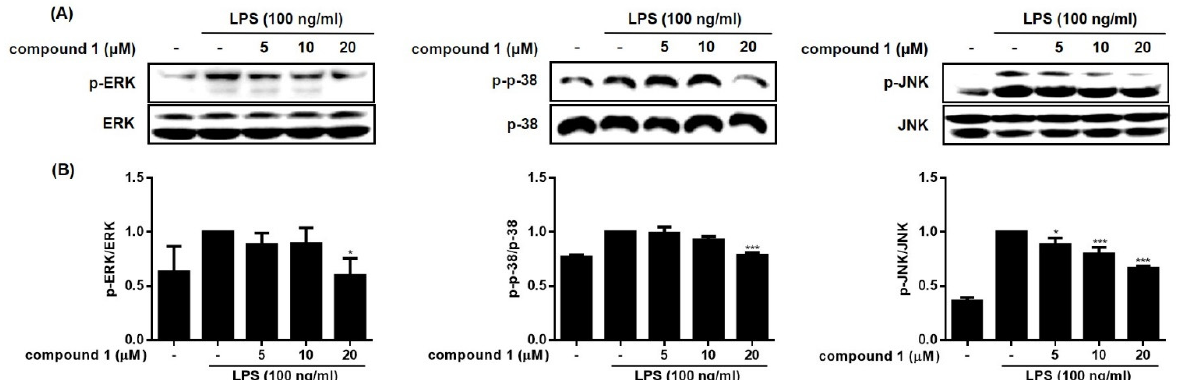
Figure 6. Compound 1 attenuated the phosphorylation of mitogen-activated protein kinase (MAPK) family in RAW264.7cells. The RAW264.7 cells were pretreated with the compound (5, 10, and 20 µ M) for 1 h before exposure to LPS for 24 h. The phosphorylated MAPKs (JNK, ERK, and p38) were analyzed using Western blotting. The representative blots ( A ) and the calculated intensities after normalization to α -tubulin ( B ) were presented. Results are presented as the mean ± standard deviation from three independent experiments. The results differ significantly from LPS-only treated; * p < 0.05, *** p < 0.001.